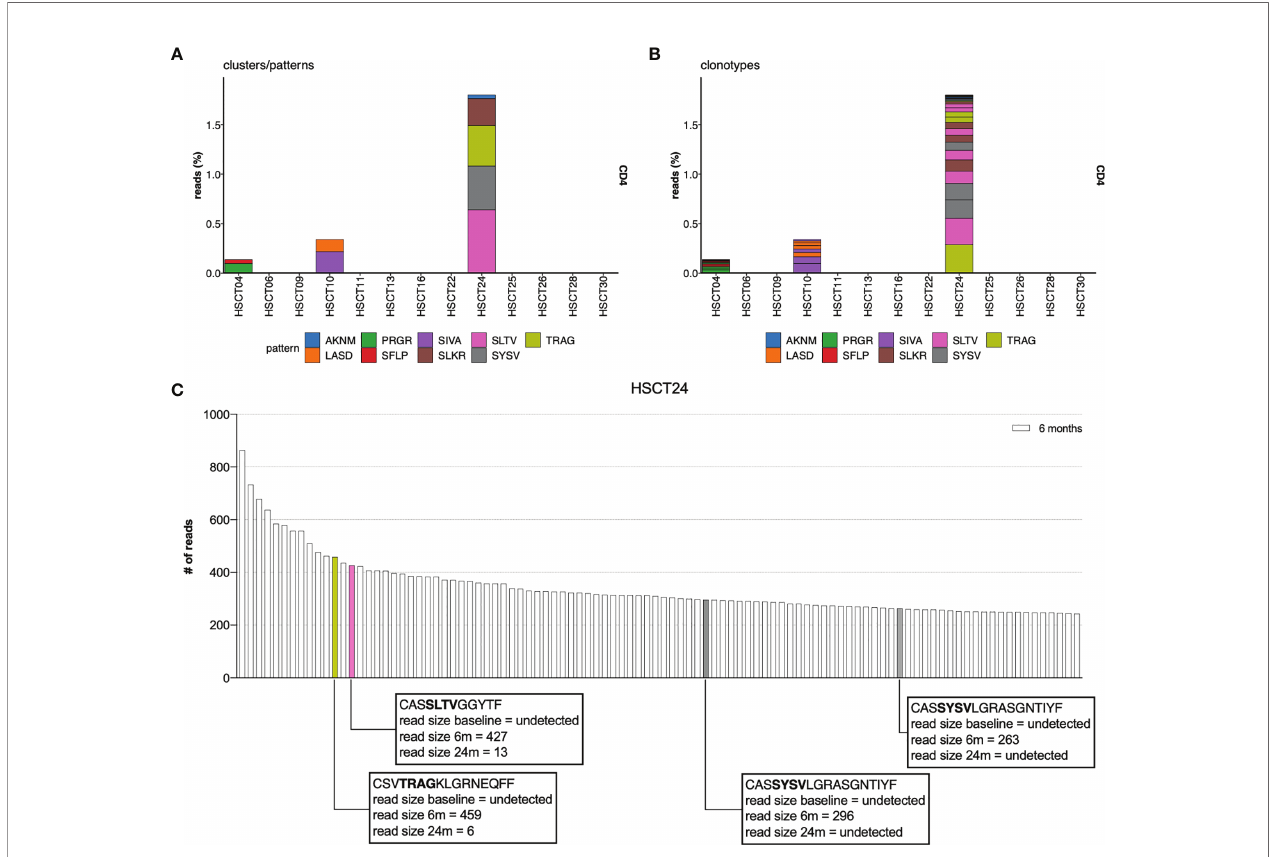
FIGURE 5 | TCR CDR3 motif analysis. TCR CDR3 motif analysis compares the 6-month CD4+ TCR repertoire to the 0 (pre), 12, 24 and 36 months for AHSCT subjects. Signi fi cantly enriched motifs were identi fi ed only in the CD4+CD45RO+ population at 6 months in relation to pre-AHSCT. (A) The proportion of overall read count that included each enriched motif cluster. (B) The proportion of clonotypes within each individual at 6 months which contain enriched motifs. (C) Identifying speci fi c T-cell clones undergoing LIP in patient example HSCT24. Enriched motifs were detected in 4 of the top 100 clones at 6 months. Clones containing enriched motifs at 6 months have been colour coded to their relevant motif eg: SLTV coded pink. CASSYSVLGRASGNTIYF is encoded by two different nucleotide sequences. Read size pre- and 24-months post-AHSCT has been